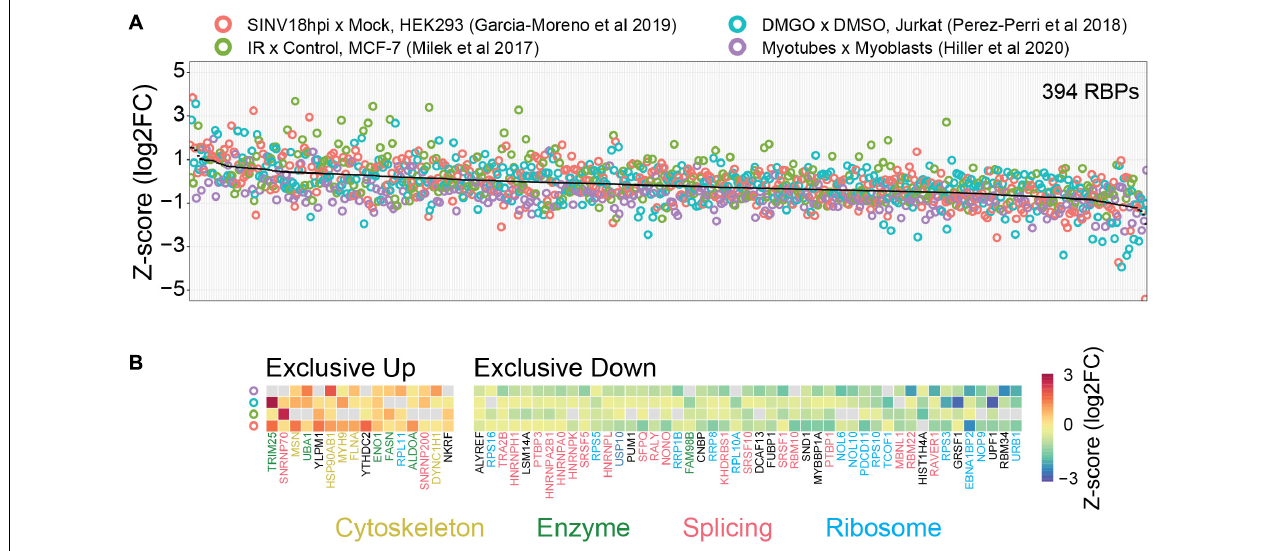
FIGURE 2 | Possible link between baseline RBP occupancy and observed changes in comparative RIC experiments. We used published data from four different cellular systems and perturbations [HEK293 cells infected with Sindbis virus (SINV), Infrared (IR) radiated MCF-7 cells, DMGO treated Jurkat cells, and differentiated myoblasts (myotubes)]. (A) Intra-experimentally z -scored log2 fold changes for 394 RBPs quantified in at least three experiments. Proteins were ranked by their mean fold change (black line). (B) RBPs exclusively up- or down-regulated in all experiments. Protein function was annotated manually. “Cytoskeleton” includes cytoskeleton dynamics-related proteins (yellow), “Enzymes” includes metabolic enzymes and protein modifiers (green), “Splicing” includes spliceosome components and splicing-related RBPs (red), “Ribosome” includes both core ribosome components and ribosome biogenesis-related factors (light-blue). We note that “moonlighting” RBPs (Cytoskeleton and Enzymes) and “core” RBPs (Splicing and Ribosome) tend to be up- and down-regulated, respectively. See text for more